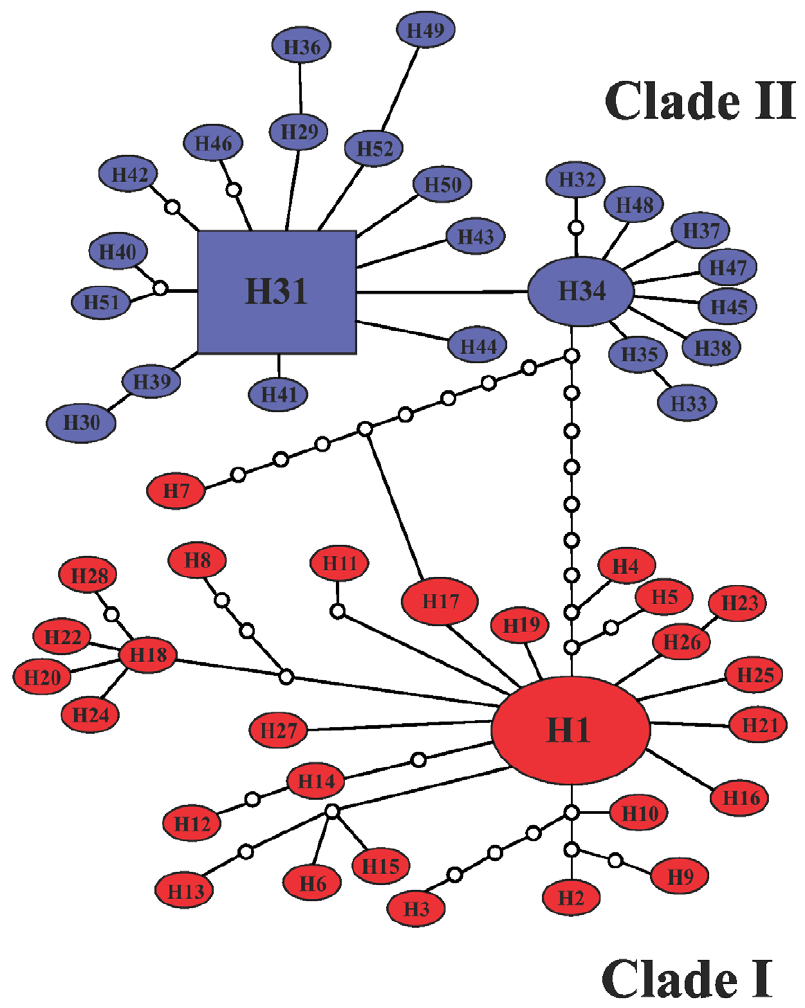
Figure 2. Parsimony haplotypes network of the 52 haplotypes of Lutzomyiaumbratilis . H1 to H52, haplotypes. The haplotype circle sizes are proportional to number of individuals observed in each haplotype. Empty smaller circles represent mutational events. Clades I and II are in red and blue colors, respectively. ( r ) calculated for all samples and clades did not reject the null